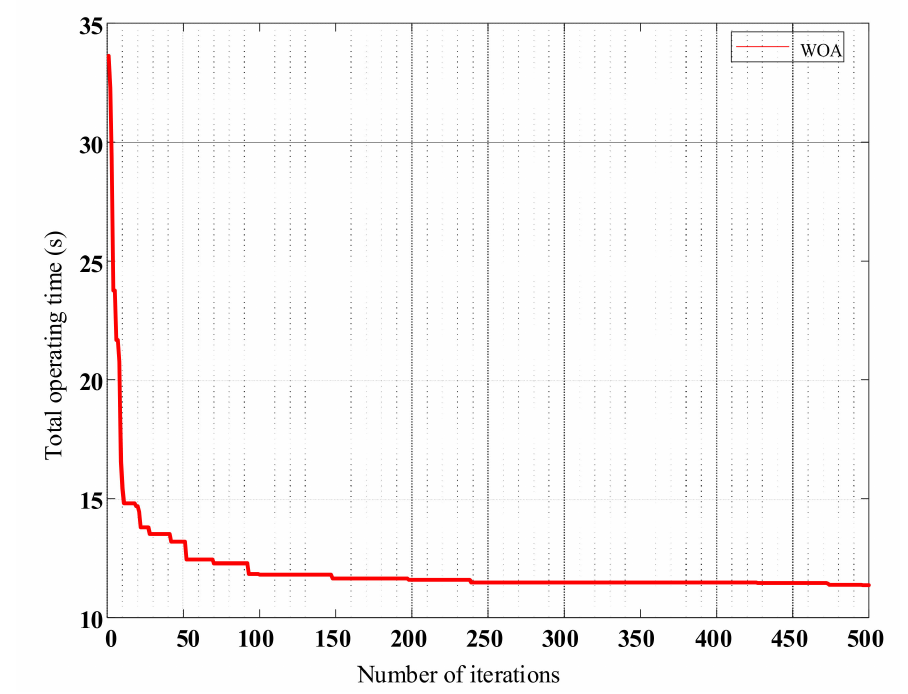
Figure 10. Convergence characteristic of WOA for Case 4. Table 13. Optimal TDS for the IEEE 15-bus